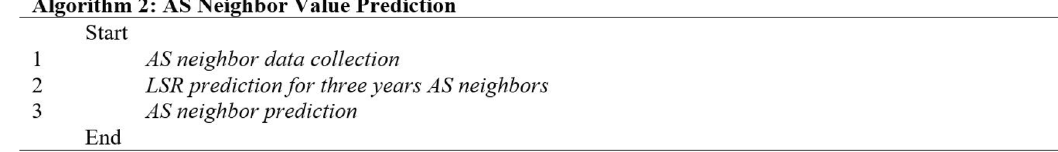
Figure 4. AS neighbor values prediction based on ML